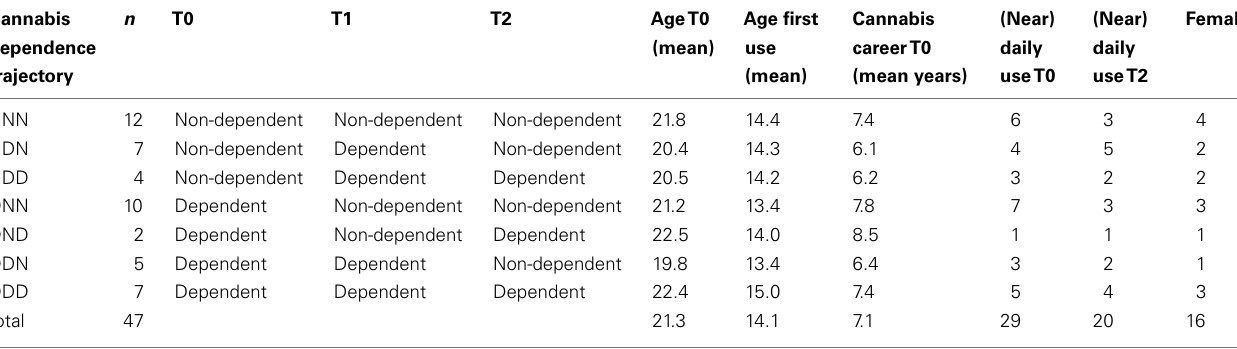
Table 1 |Transitions in cannabis dependence statusT0–T1–T2 and trajectory